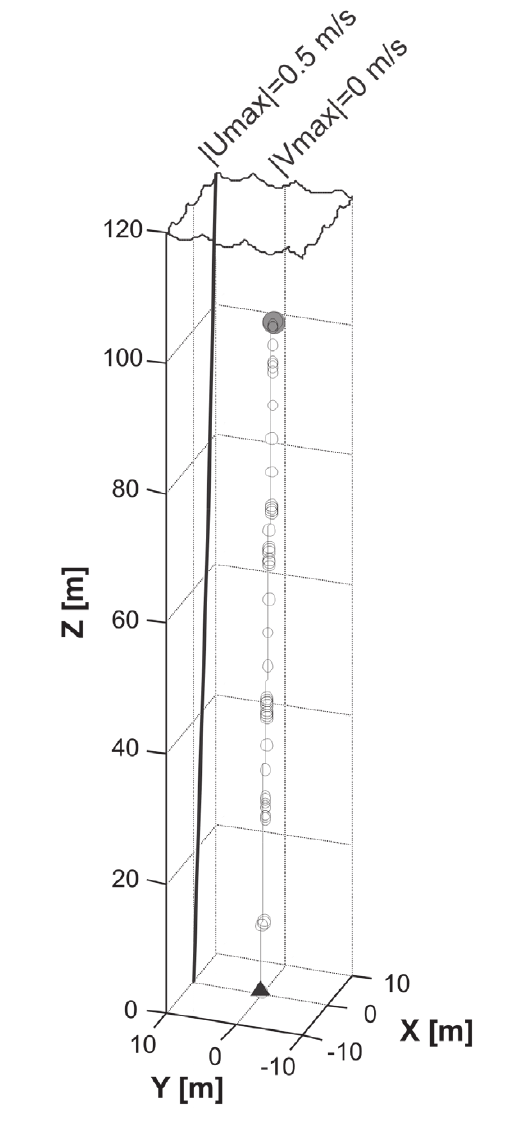
Figure 5 - Output from Matlab modeling forced by a surface velocity current of 0.5 m/s attesting the low tilt of the mooring line in Cabo